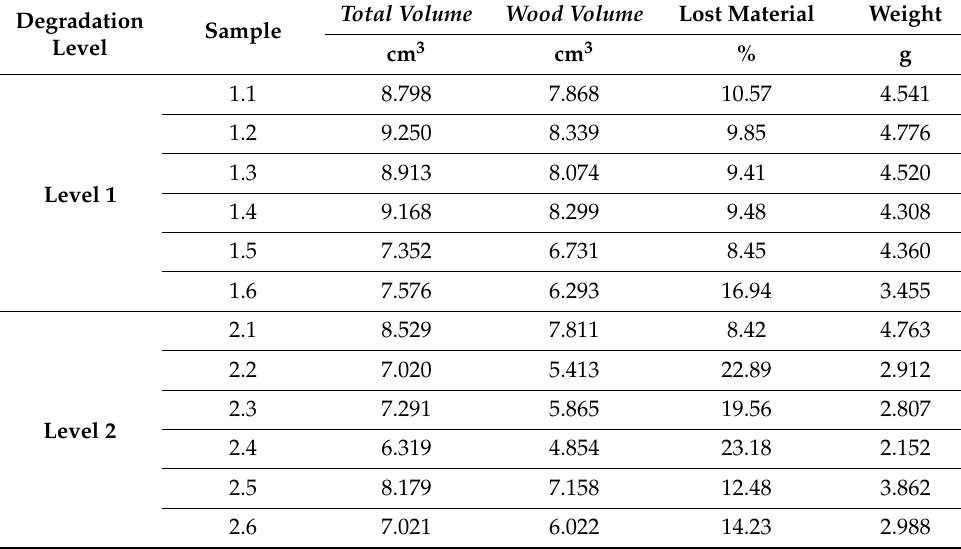
Table 4. Output parameters, lost material percentages, and sample